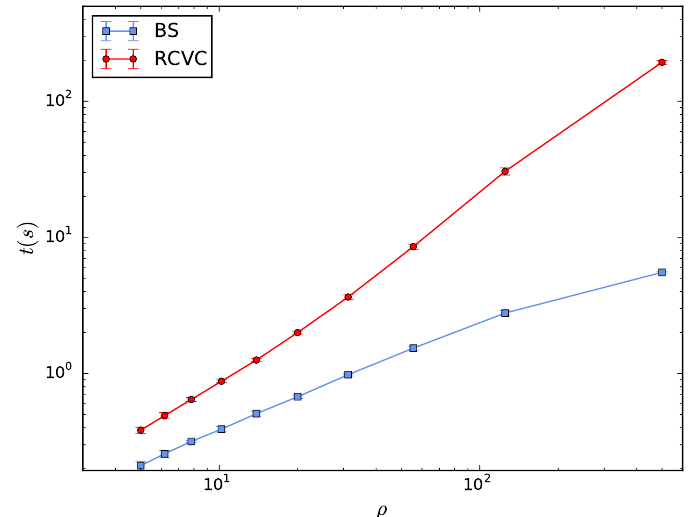
Figure 6. The computational time of the BS and RCVC algorithm versus the increasing density of